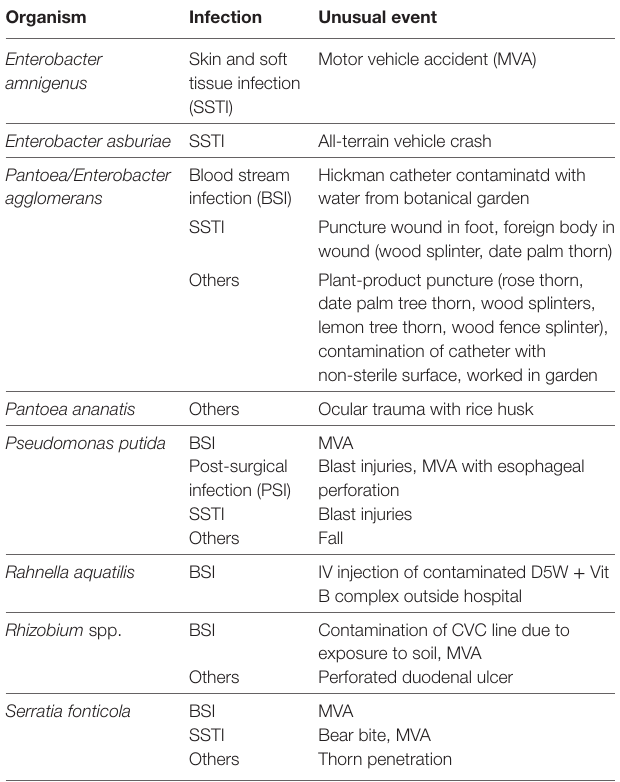
taBLe 5 | Unusual events leading to infection by saprophytic Gram-negative bacteria species.